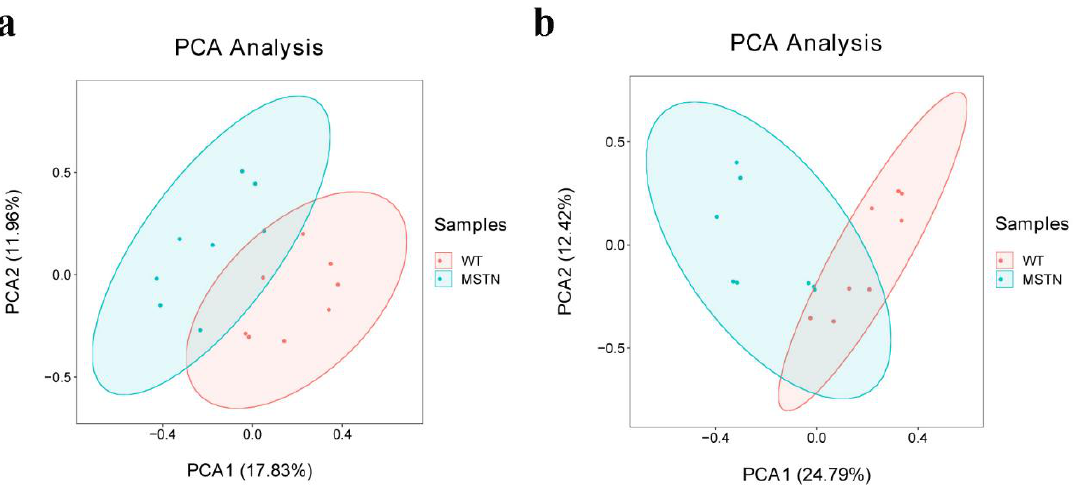
Figure 2. PCA scores of the detected compounds in the two groups. ( a ) PCA scatter plot of differen- tially expressed lipid metabolites in positive ion mode; ( b ) PCA scatter plot of differentially expressed lipid metabolites in negative ion mode.